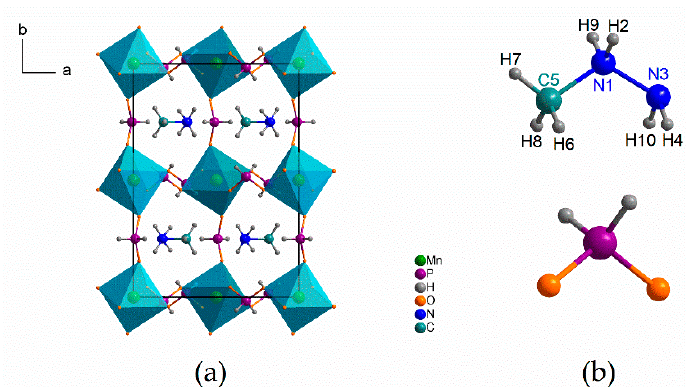
Figure 1. The crystal structure packing of [MHy][Mn(H 2 POO) 3 ] taken from Ref. [5] ( a ) and the structural model of MHy + cation (with the atomic numbering used in the Density Functional Theory (DFT) calculations) and H 2 POO − anion ( b ).